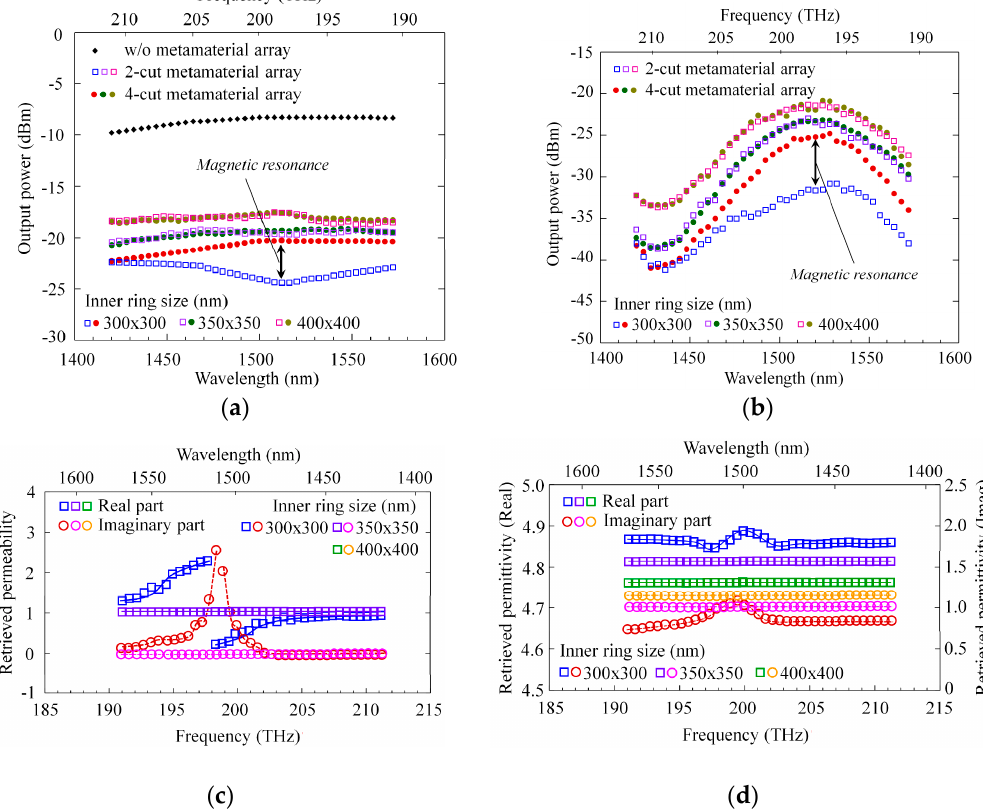
Figure 5. ( a ) Transmission spectra measured for ( a ) three waveguides and ( b ) two Mach–Zehnder interferometers (MZIs) with different ring size; ( c , d ) Retrieved relative permeability (real and imaginary parts) of substituting layer, plotted as a function of light frequency.